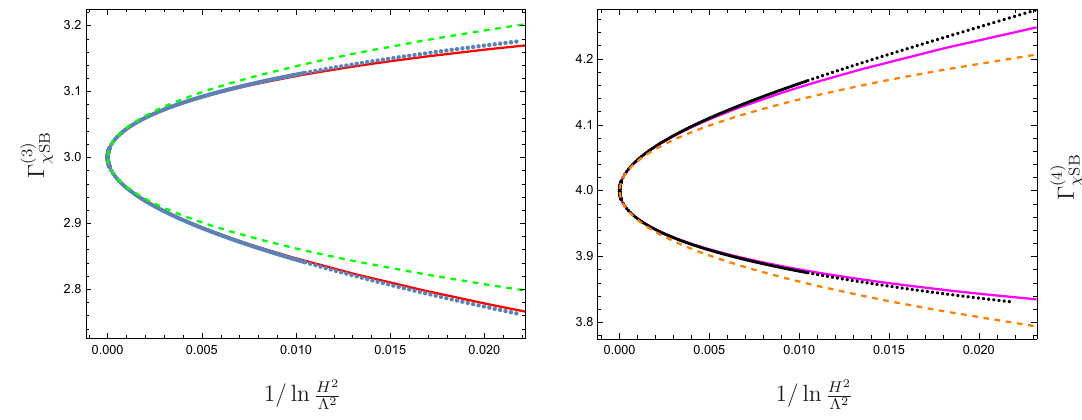
] of the chiral symmetry breaking fluctuations about Figure 4 . Attenuation Γ ( n ) ≡ − Im [ w ( n ) χ SB χ SB cascading gauge theory TypeA DFP for H (cid:29) Λ . Dashed and solid curves are correspondingly the s leading and the first subleading order corrections to the conformal spectra, see (4.4).